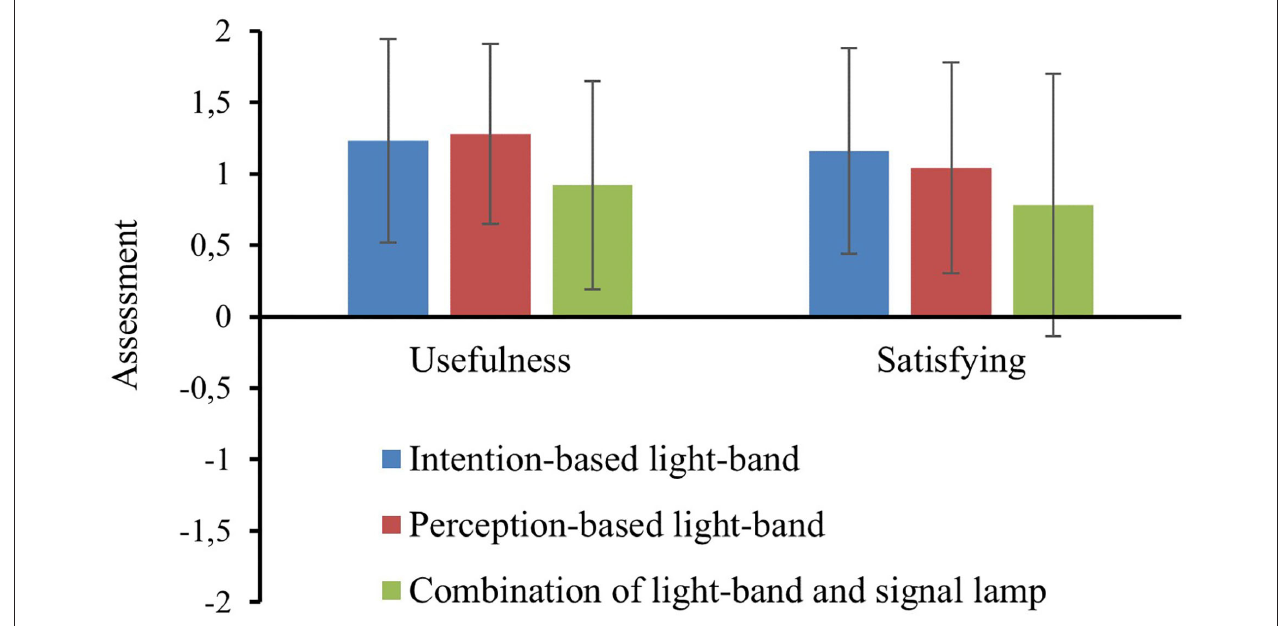
FIGURE 8 | Mean acceptance rating across the eHMI concepts. Error bars reflect ± 1 SD